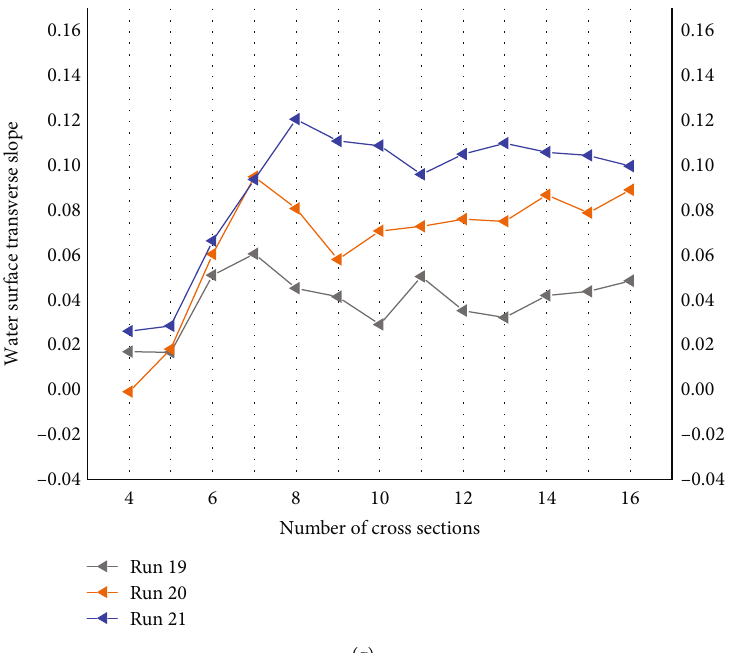
Figure 5: Distribution of water surface transverse slope in the curved spillway in 21 runs. (a) Runs 1-3; (b) Runs 4-6; (c) Runs 7-9; (d) Runs 10-12; (e) Runs 13-15; (f) Runs 16-18; (g) Runs